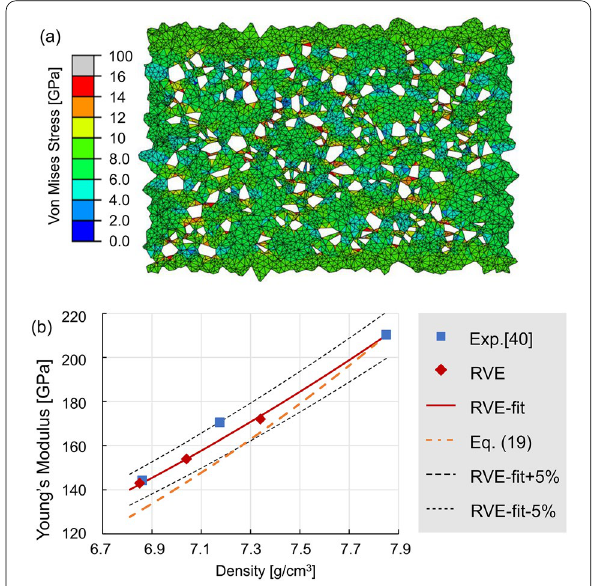
Figure 13 a Von Mises stress distribution of an RVE of Astaloy 85 Mo sample with 12.8% porosity under uniaxial tensile loading, b influence of density on the modulus of elasticity by comparing simulation results with the power law approximation (Eq. (19)) and experimental investigations from Ref.